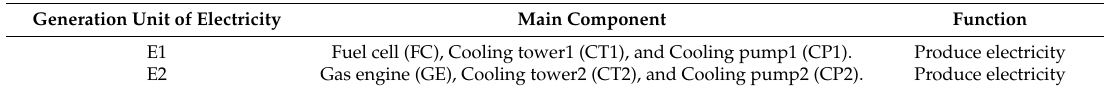
Table 5. The electricity subsystem of CCHP system.